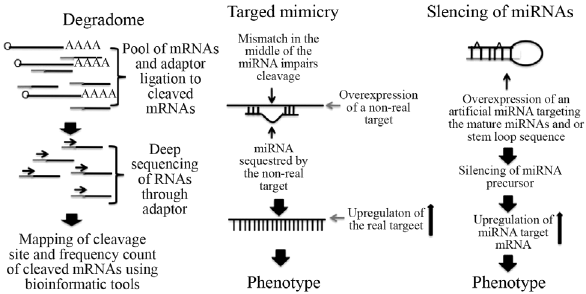
Figure 3 - General representation of the degradome sequencing approach, miRNA target mimicry, and silencing of miRNAs. The degradome se- quencing approach has been used to detect miRNA target genes through deep sequencing of cleaved mRNAs and mapping of cleaved sites. Target mimicry is a suitable molecular tool that is based on the expression of a transgene carrying a non-real target of a miRNA that is partially comple- mentary to the miRNA. This RNA contains three to four nucleotides that arenotcomplementarytoacoreregioninthemiddleofthemiRNA,which causes the sequestration of miRNAs, blocks cleavage and up-regulates the real target mRNAs. Silencing of miRNAs triggered by artificial miRNAs targeting the mature and or precursor miRNA, directs cleavage and RNA silencing of the precursor miRNAs and upregulation of miRNA target